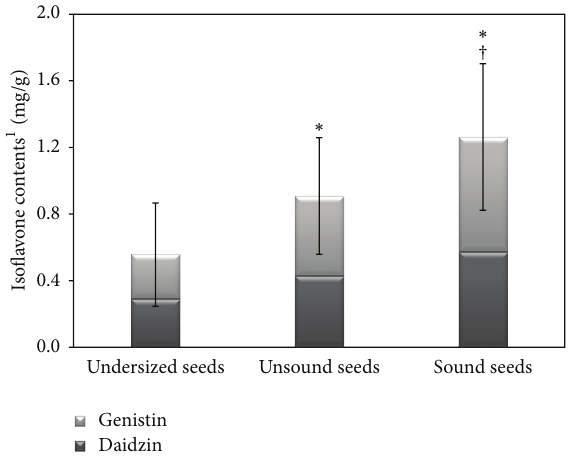
Figure 4: Isoflavone content in 14 soybean varieties planted at SUT Farm on 19 December 2009, categorized according to physical seed quality. Each soybean sample was extracted and assayed in triplicate ( 𝑛 = 3 ). Bars and error bars represent mean ± standard deviation. ∗ 𝑃 < 0.05 compared to undersized seeds. † 𝑃 < 0.05 compared to unsound seeds. 1 Isoflavone content was the summation of daidzin and genistin contents.